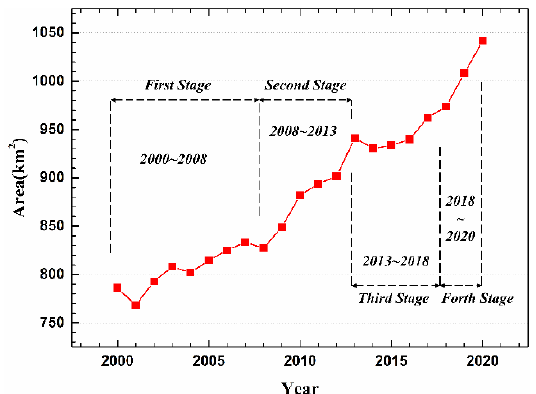
Figure 4. Total surface water area in the ZSLB from 2000 to 2020.